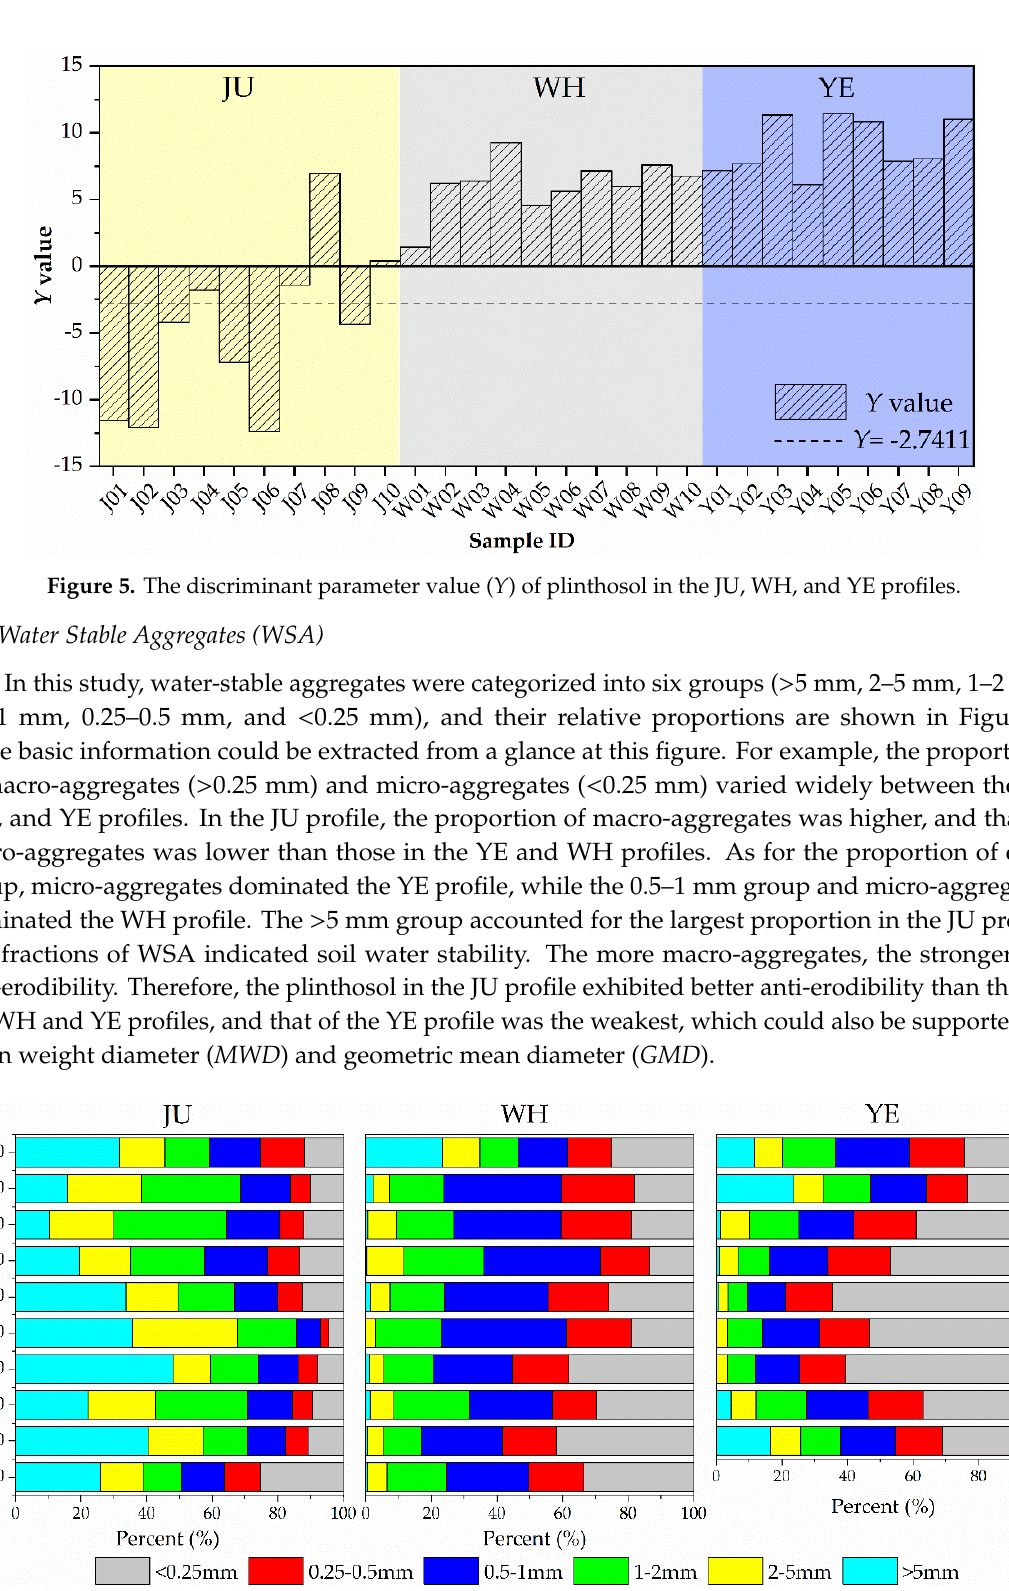
Figure 6. Relative proportion of water-stable aggregates (WSA) in the JU, WH and YE profile.